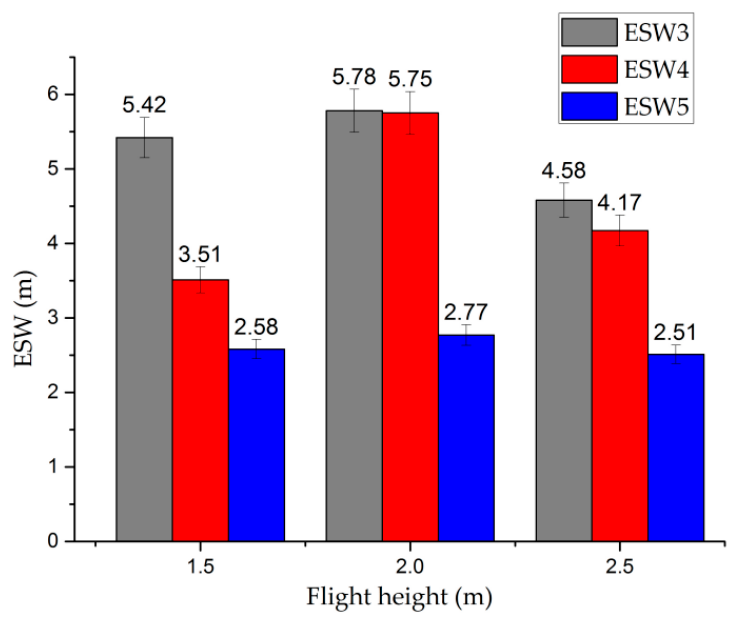
Figure 4. Effective spraying width (ESW) changes under different speeds. Note: ESW1.5, ESW2.0, ESW2.5 represent the ESW when the flight height (FH) was 1.5, 2.0, and 2.5 m, respectively.